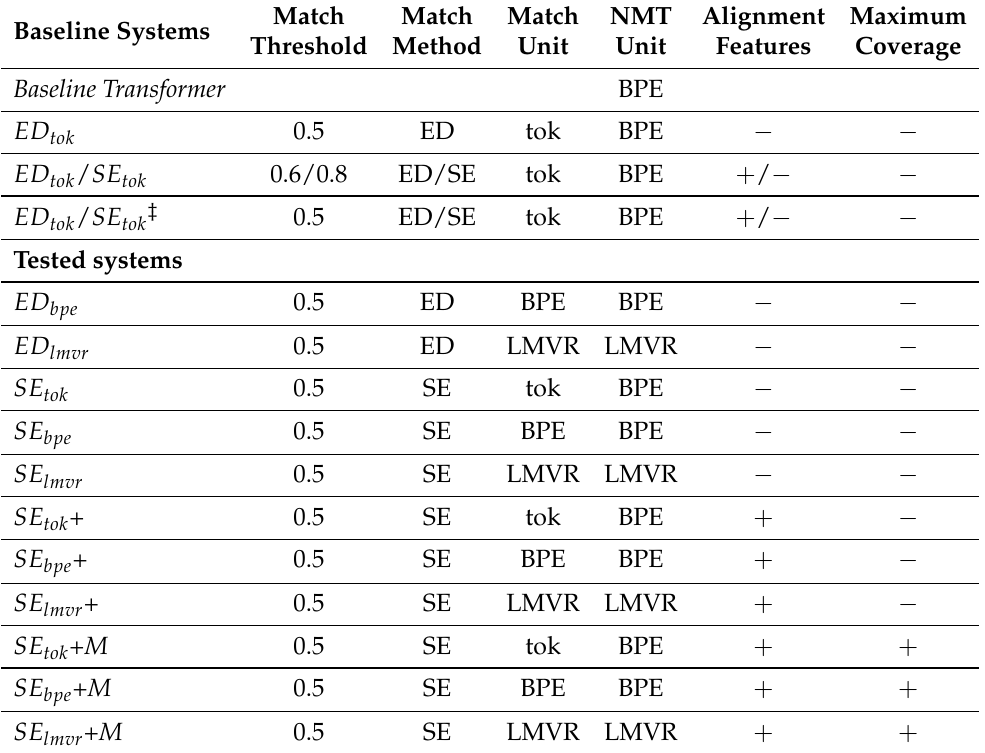
Table 3. Summary of the systems evaluated in this study for English ↔